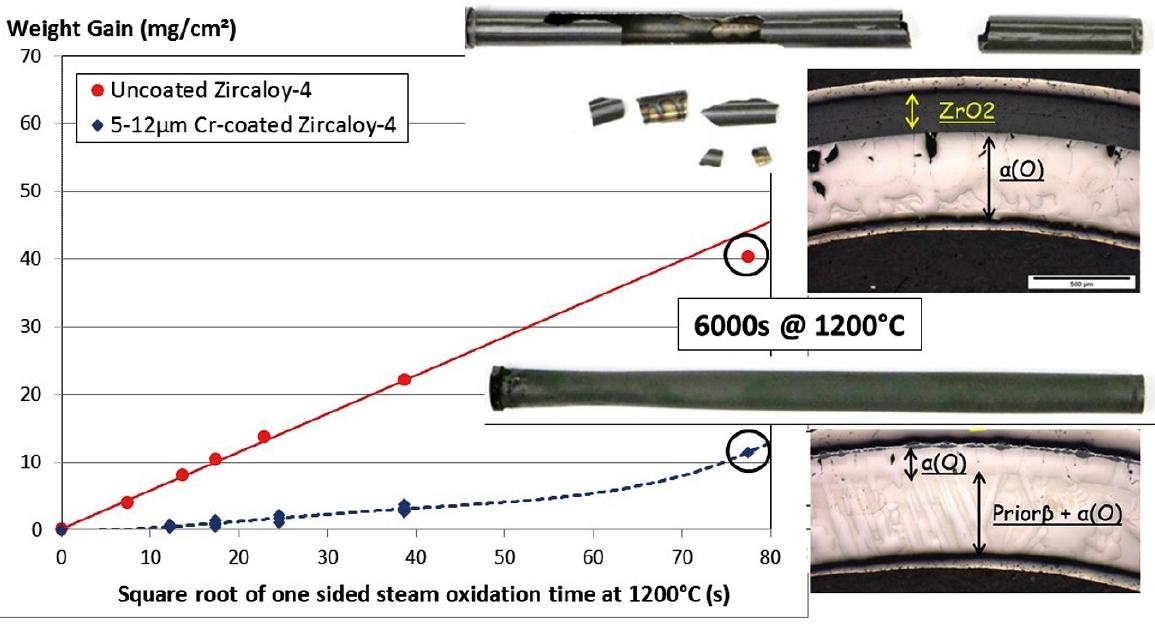
Figure 4. Optical images and weight gain evolution of uncoated and Cr-coated (5–12 µm) Zry-4 alloy during steam oxidation at 1200 °C. Reproduced from [87] with permission by Elsevier.